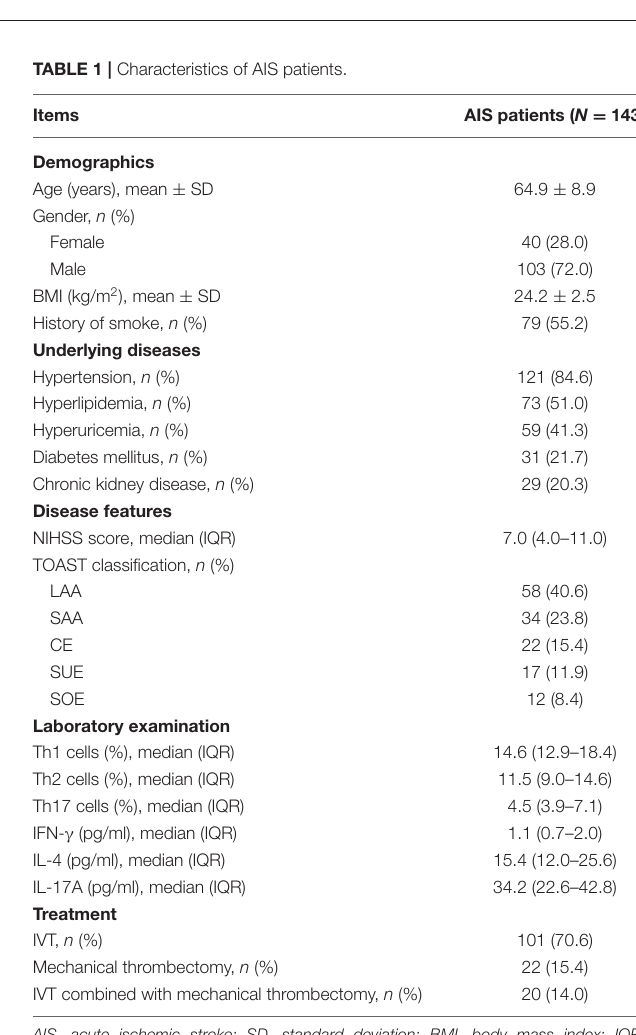
FIGURE 1 | Study flow.